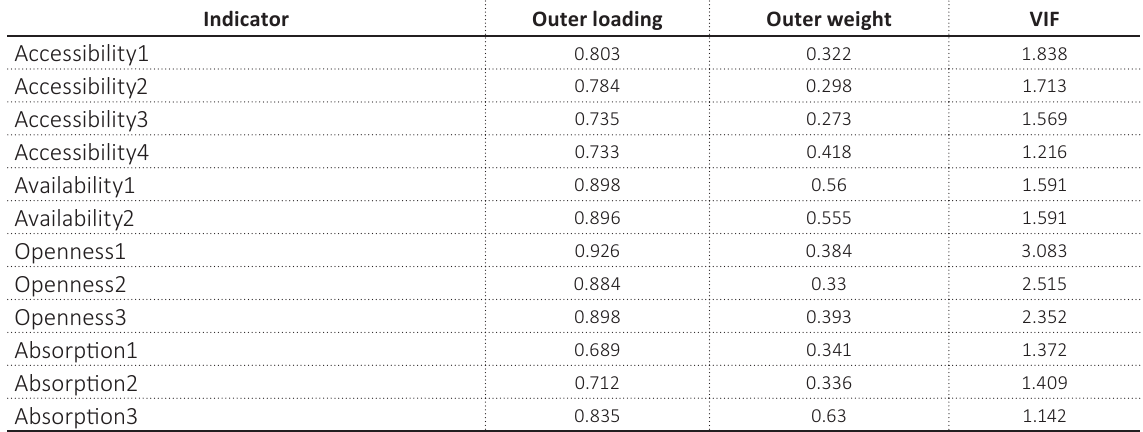
Table 4. Outer loading, outer weight, and VIF for each